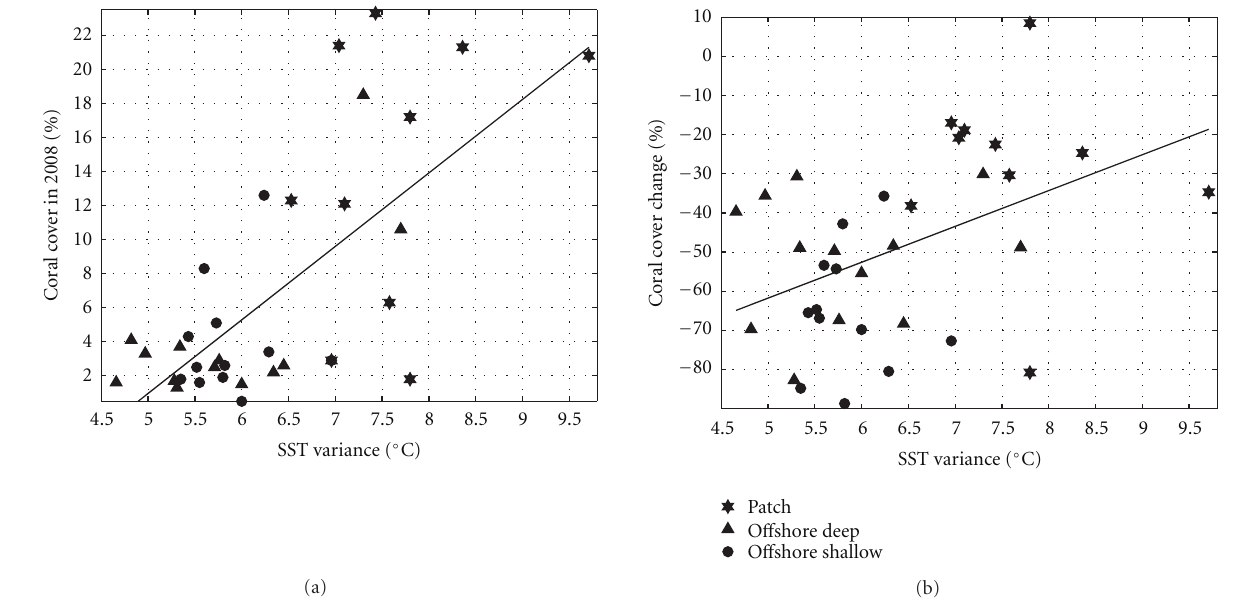
Figure 2: (a) Comparison between percentage of coral cover in 2008 and weekly SST variance from 1994 to 2008 ( r = 0 . 70, P = 2 . 9 × 10 − 6 , robust fit equation: y = 0 . 04 × − 0 . 21, N = 35). (b) Comparison between percentage of coral cover change from 1996–1999 to 2008 and weekly SST variance from 1994 to 2008 ( r = 0 . 44, P = 0 . 008, robust fit equation: y = 0 . 09 × − 1 . 08, N = 35; note inverted scale in y -axis).